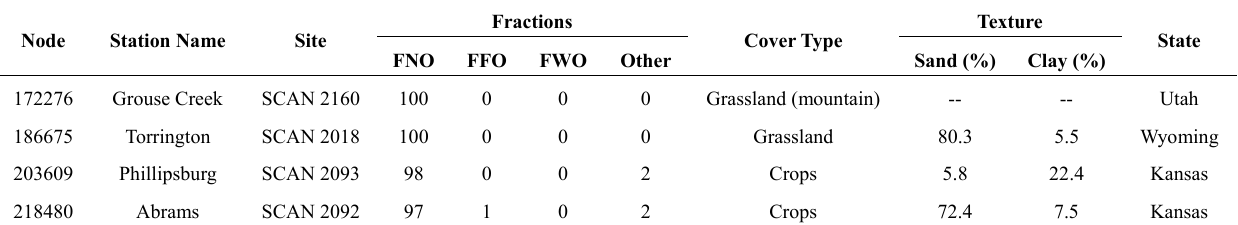
Table 1. Description of the DGG nodes representative of the selected SCAN sites from [41] (FNO: Nominal fraction, FFO: Forest fraction, FWO: Water